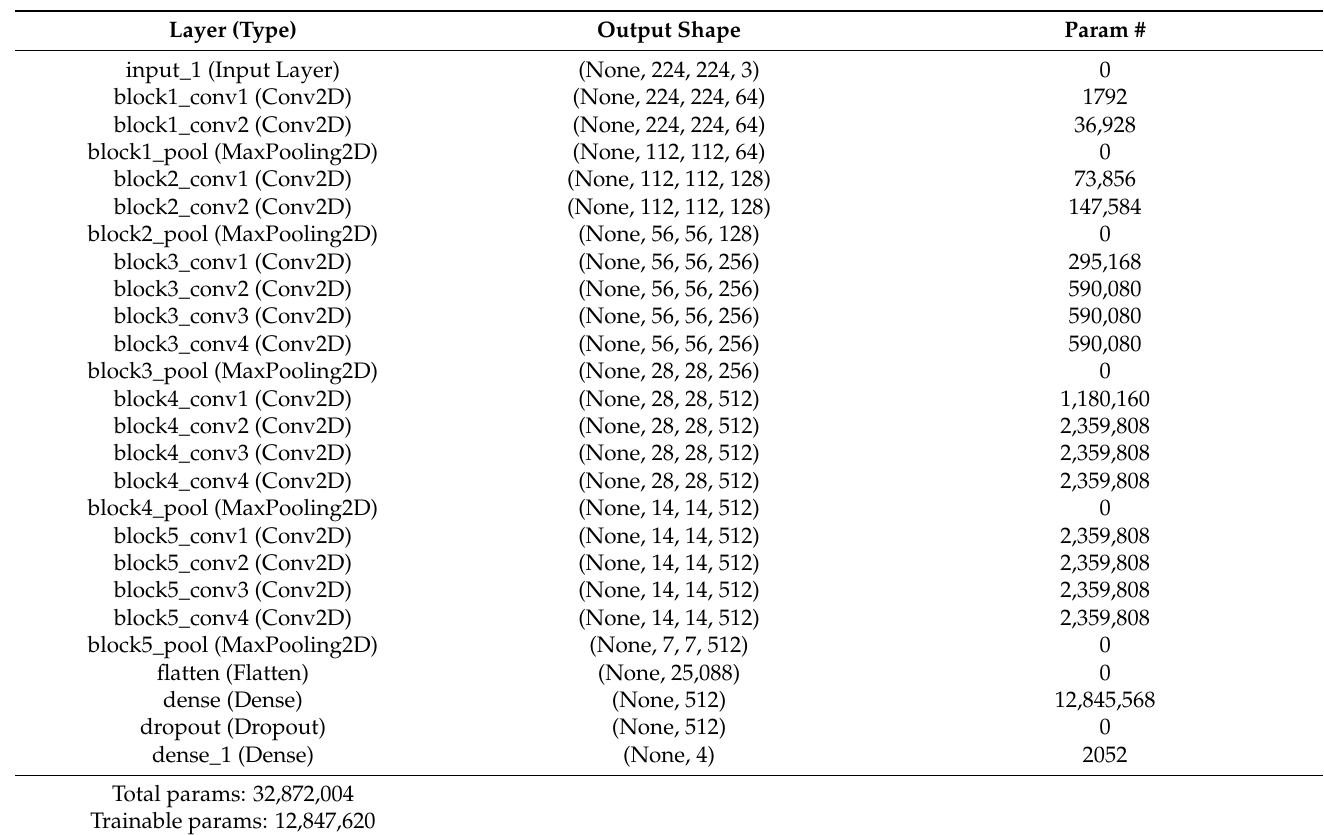
Table 10. Layers of VGG19.